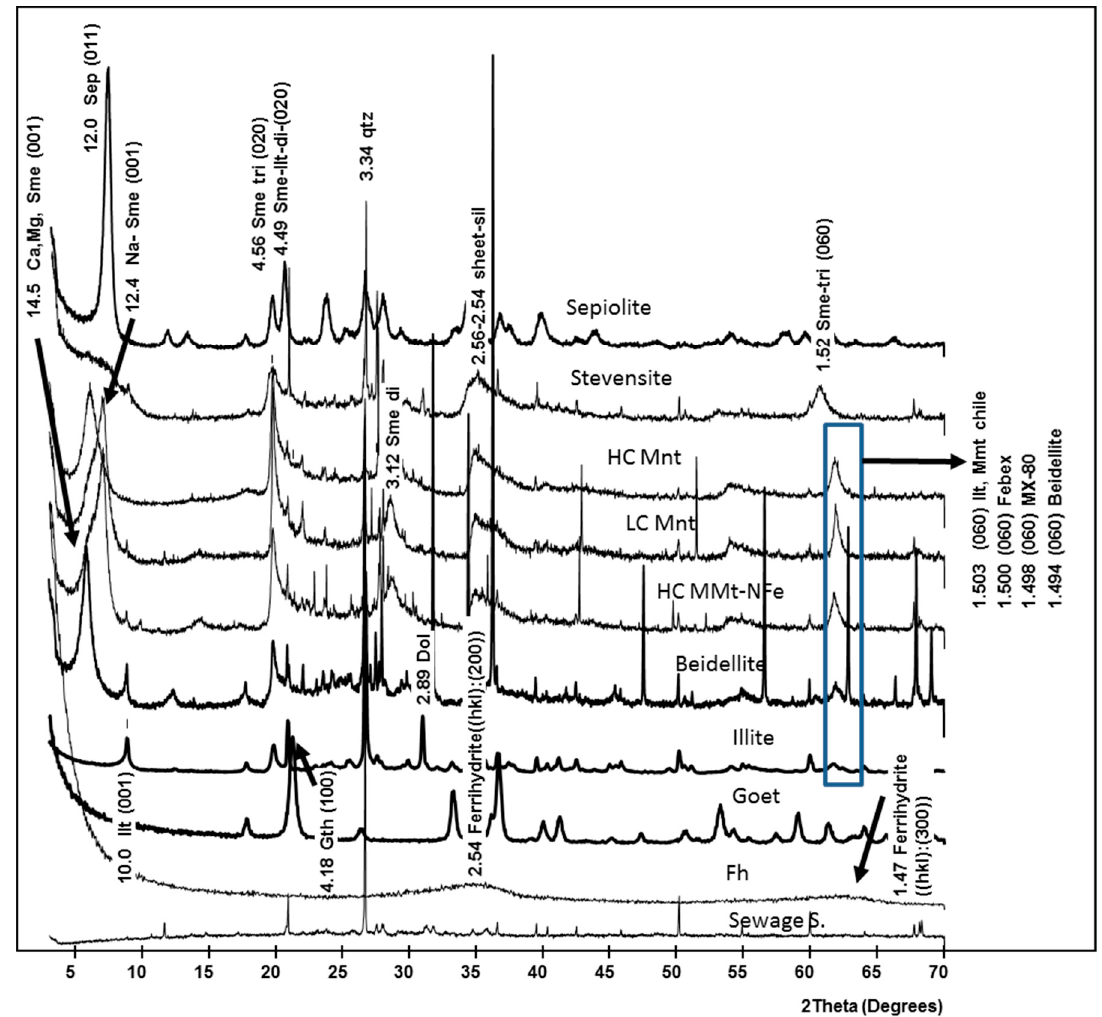
Figure 2. X-ray diffraction (XRD) powder patterns from different mineral sorbent materials. The main reflections identifying minerals and used in crystal size calculations (csc) are quoted and marked in Å units. (hkl) The Miller index is incorporated for csc peak reflections. Sep: sepiolite, Sme: smectite,